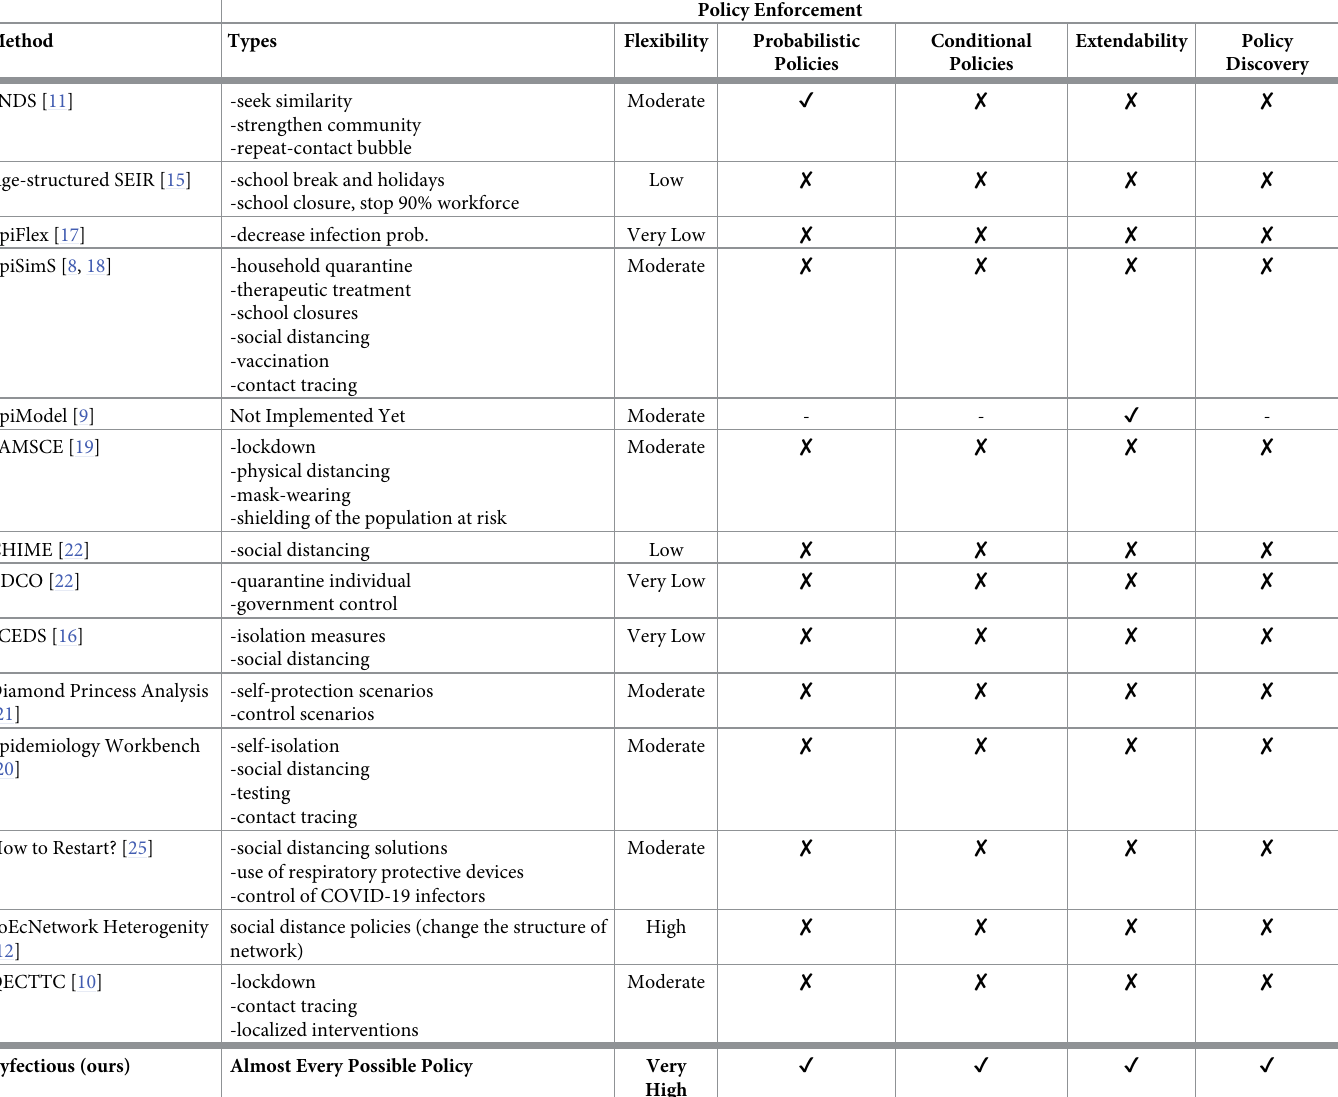
Table 3. Comparing simulation softwares in terms of the policy enforcement methods. Entries indicated by “-” for EpiModel [9] show that polices are not imple- mented